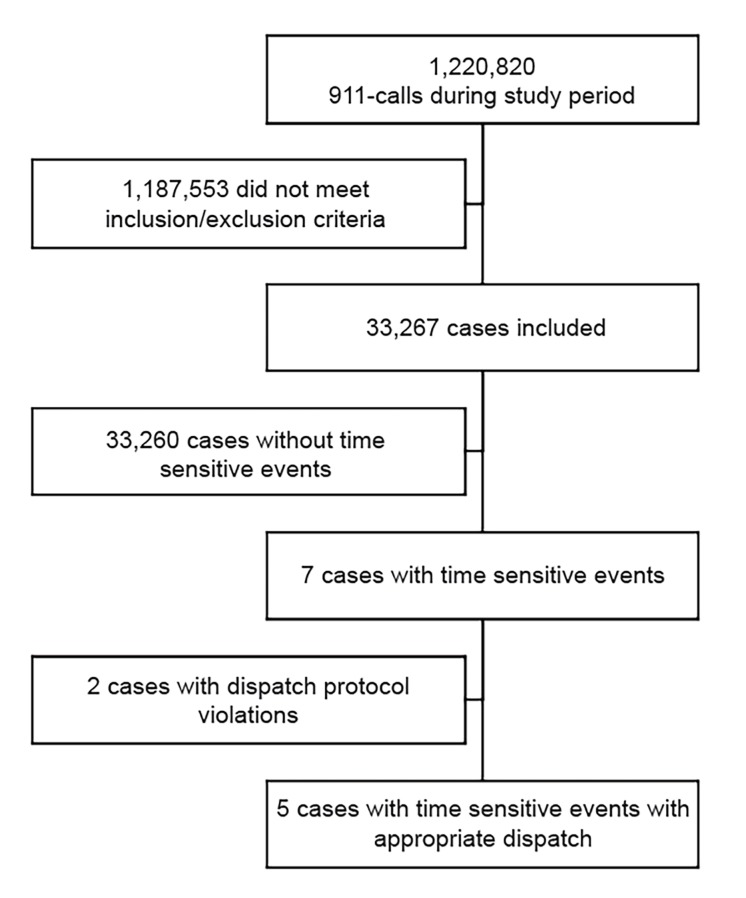
Study flow chart.